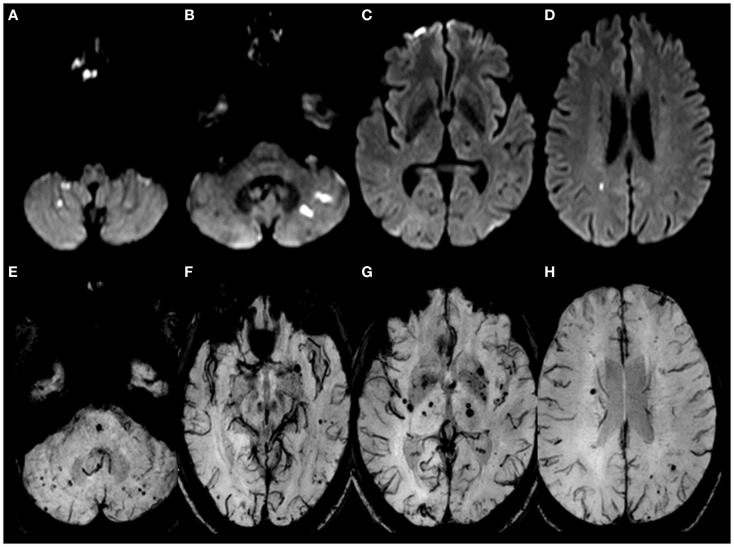
Brain MRI performed during the previous ischemic stroke 4 months earlier. (A–D) DWI showed restricted fluid diffusion in cerebellar hemispheres, left temporal cortex, right parietal deep white matter consistent with acute infarctions. (E–H) SWI-MRI (susceptibility weighted imaging MRI) showed multiple cerebral microbleeds, particularly in the deep gray matter and posterior fossa, possibly due to hypertensive vasculopathy.